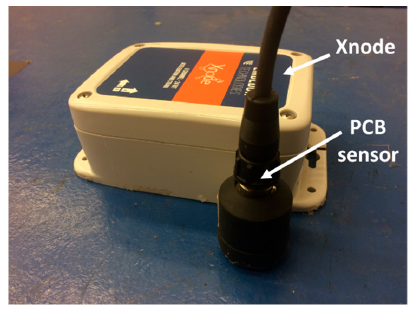
Figure 10. Ambient vibration test in basement.